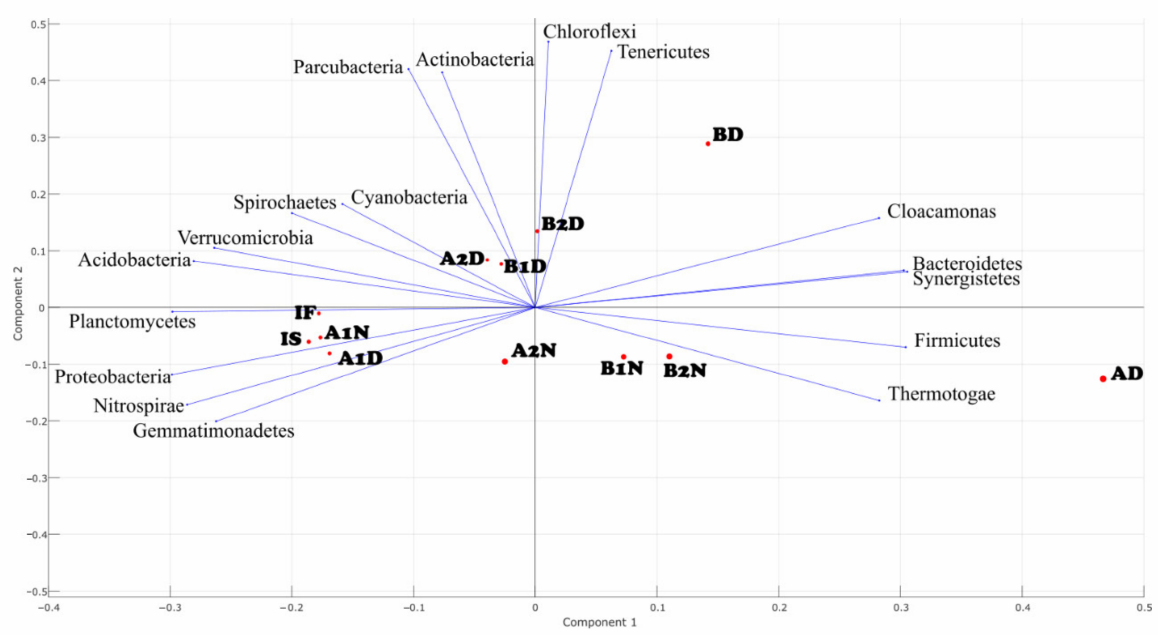
Figure 6. PCA plot comparing the phylum-level taxonomic profiles of microbial communities. A and B indicate acetate and butyrate, respectively, and N and D represent nitrification and denitrification, respectively. Initial sludge (IS) microbial communities were compared to those in final nitrification samples